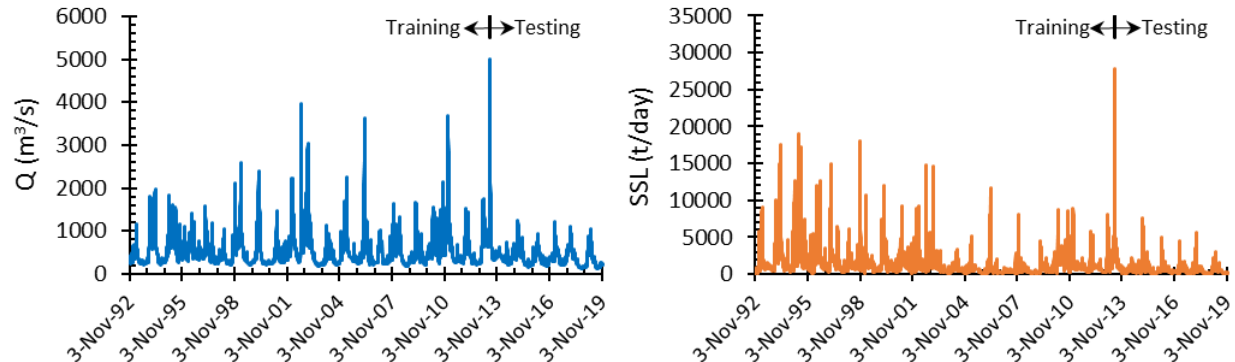
Figure 2. River flow and SSL time series for the Pirna gauging station.